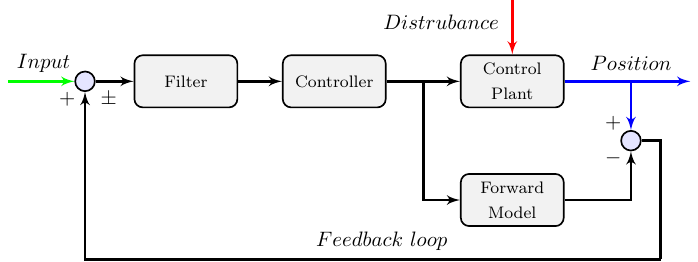
Figure 5. A general representation of the internal model control. The design concept of the internal model control is to compensate for errors or make adjustments from the desired outputs. Thus, two primary parts of the control algorithm are the forward model and feedback loop used to enhance the control